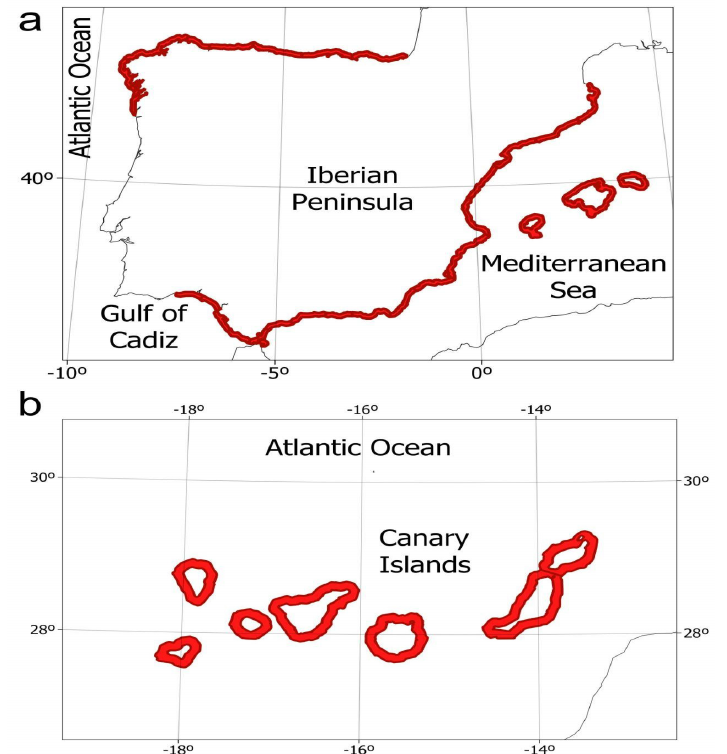
Figure 2. Map of tsunami alert zones (red polygons) to disseminate tsunami warnings to Civil Protection by the Spanish TWS. ( a ) Shows tsunami alert zones in the Iberian peninsula and vicinity, and ( b ) in the Canary islands.